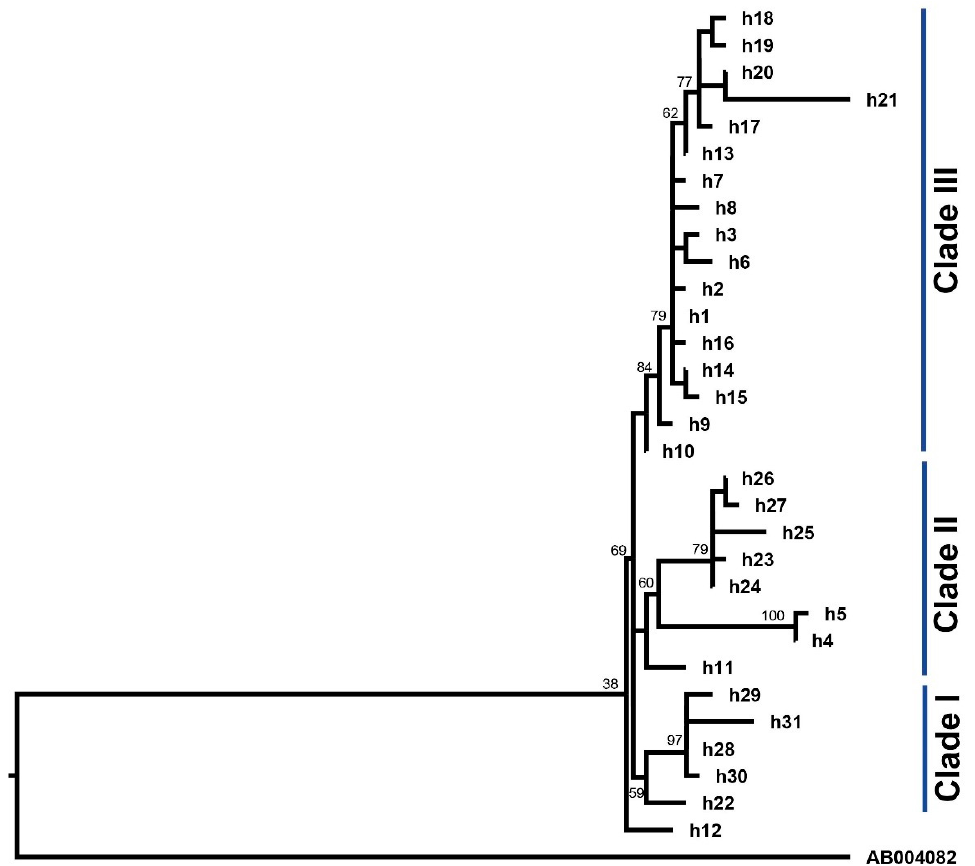
Figure 4. Phylogenetic tree inferred from maximum likelihood based on the analysis of 31 haplotypes found in five breeds of Colombian Creole sheep. Capra hircus (AB004082) was used as outgroup.